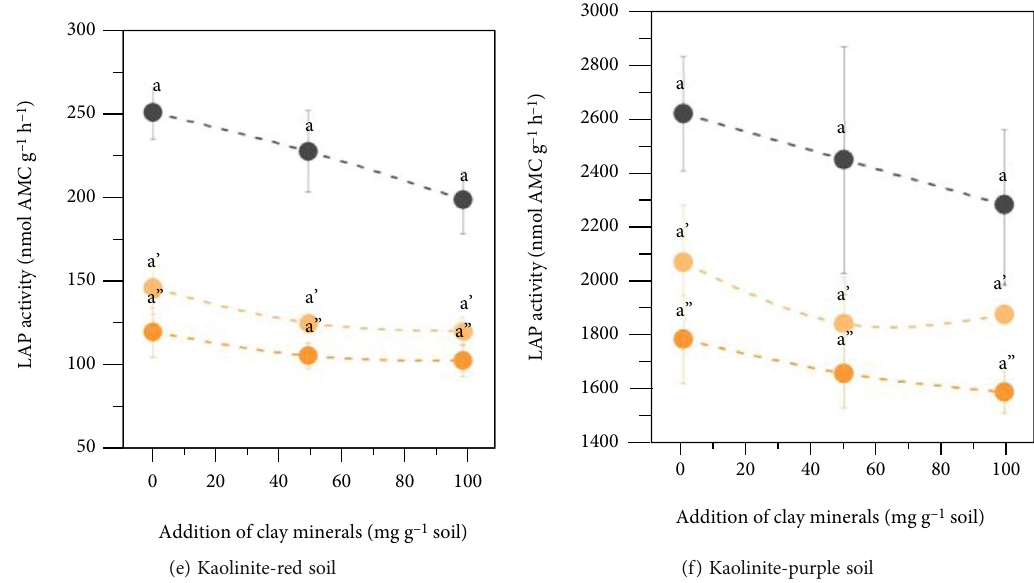
Figure 6: E ff ect of montmorillonite and kaolinite on the activity of puri fi ed LAP, LAP in red soil, and LAP in purple soil in the presence of 0, 4, and 10 μ molL -1